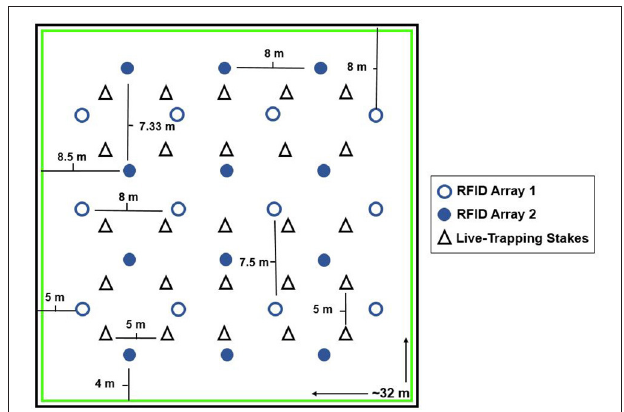
FIGURE 1 | The layout of both RFID antenna arrays and the grid stakes used as locations for live-trapping in both enclosures. RFID Array 1 is depicted by open circles, (12 antenna each 7.5 or 8m apart) whereas Array 2 is depicted by filled circles (12 antenna each 7.33 or 8m apart). The 5 × 5 grid for live-trapping is shown by the triangles. Two Ugglan live-traps were placed at each of the 25 grid stakes (all stakes approximately 5 meters apart). The green box represents the 1m that was mowed around the edge of the enclosure to prevent voles from digging near the walls. Note that we had two enclosures in this same